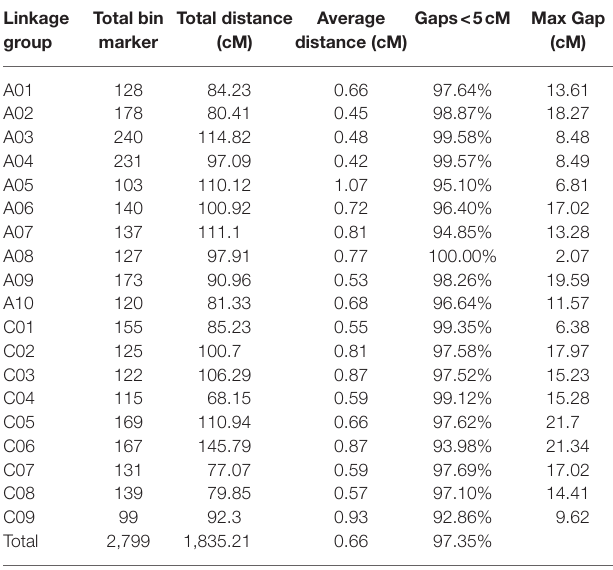
TABLE 4 | Characteristics of the high-density genetic map. Linkage